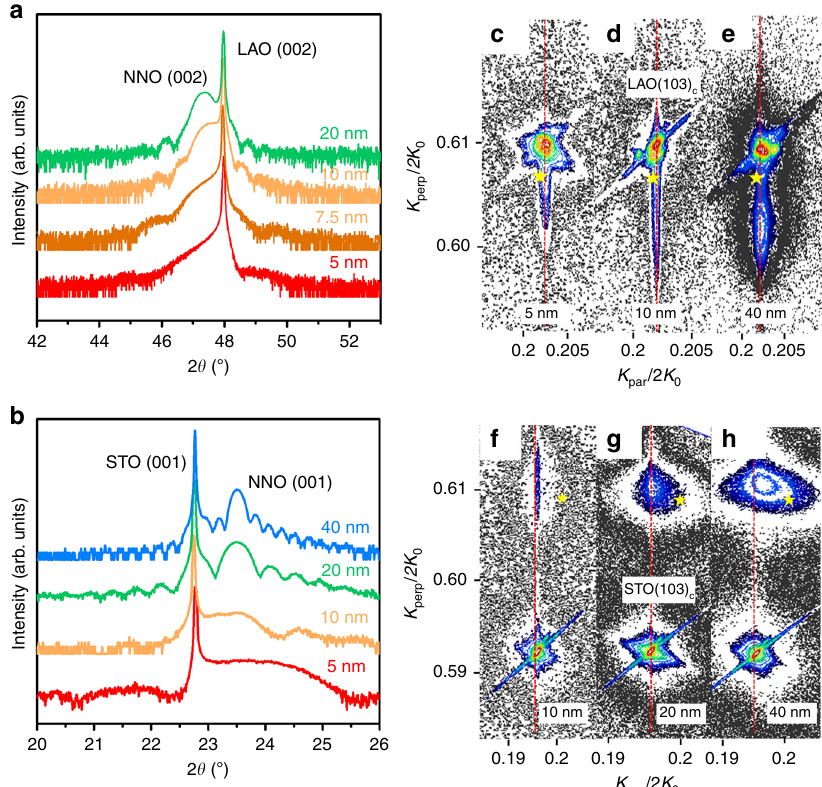
Fig. 3 Structural characterisation. X-ray diffraction patterns around the 002 re fl ection of NNO/LAO fi lms ( a ), and around the 001 re fl ection of NNO/STO fi lms ( b ) with different thicknesses. Reciprocal space map (RSM) around the (103) fi lms, c diffraction peaks of c 5-nm, d 10-nm and e 40-nm NNO/LAO and f 10-nm, g 20-nm and h 40-nm NNO/STO fi lms. The abscissa, K perp , (ordinate, K par ,) represents the in-plane (out-of-plane) component of the scattering vector. Both are normalised by 2 k 0 = 4 π / λ . The red dashed lines are guides to the eyes showing the substrate in-plane lattice. The yellow stars signal the (103) c peak of bulk